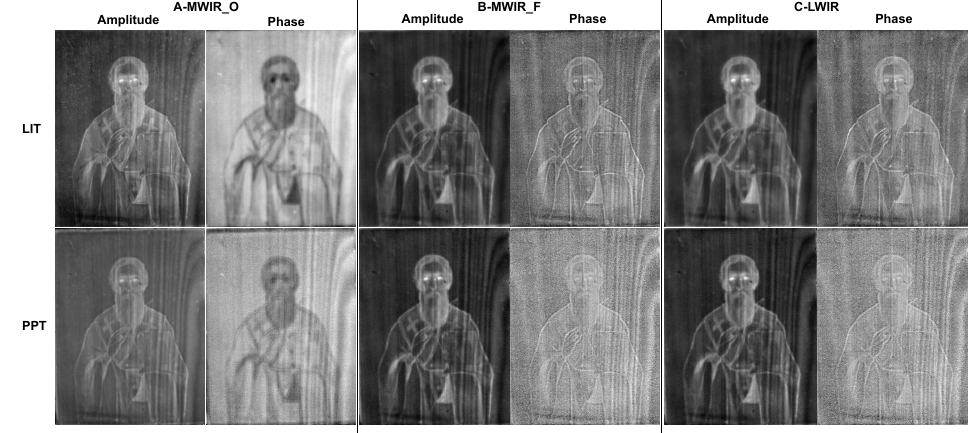
Figure A1. All measurement results for the icon, grouped by camera and technique.